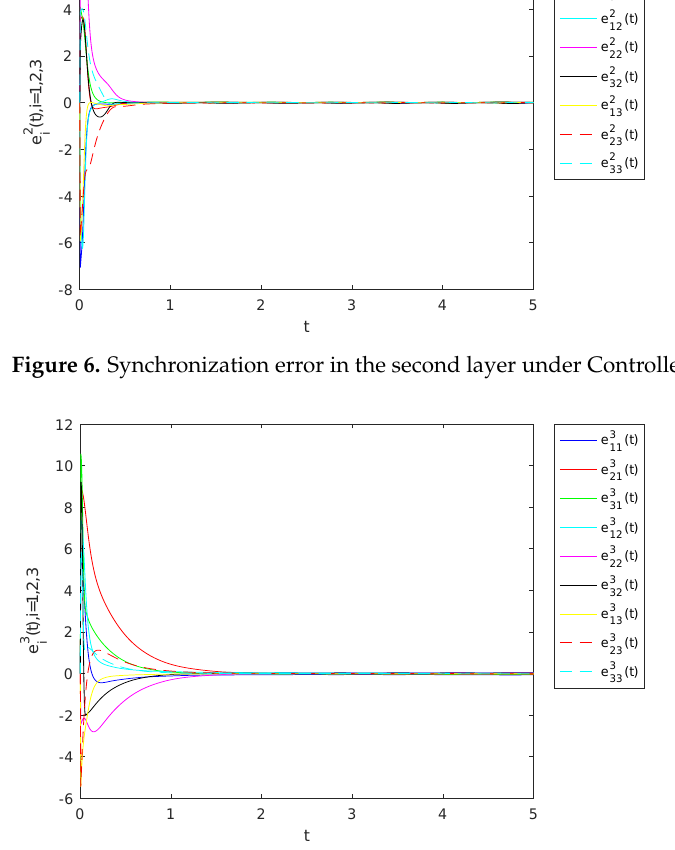
Figure 7. Synchronization error in the third layer under Controller